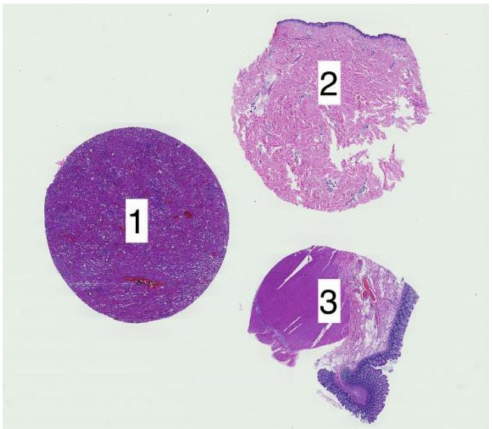
Figure 1. Randomly chosen WSI, label 1 for kidney, 2 for skin, and 3 for colon tissue.